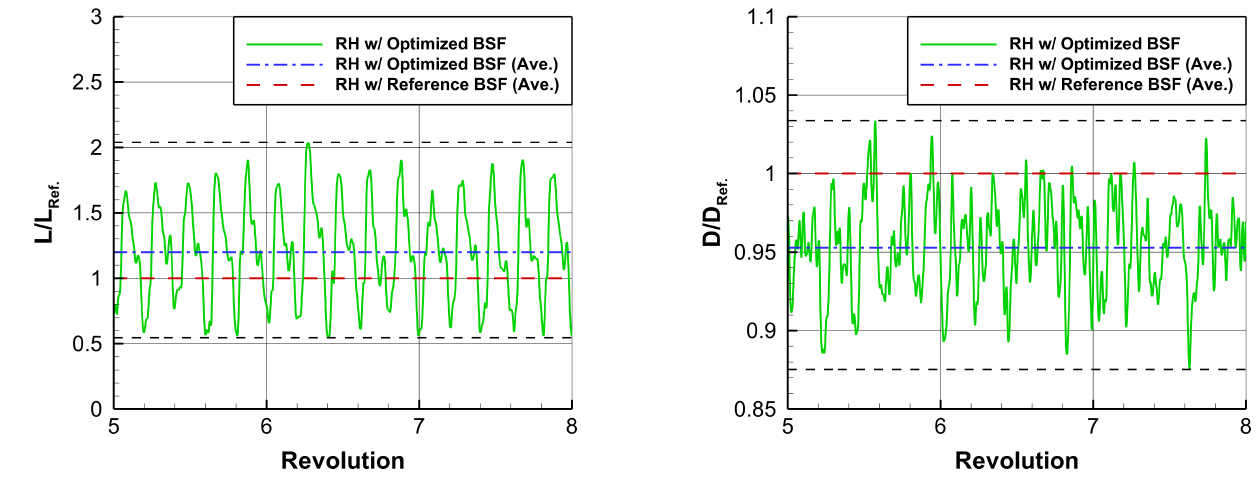
Figure 16. Total lift and drag of the isolated rotor head for the final three rotor revolutions. The forces are normalized by the average values of the reference rotor head.